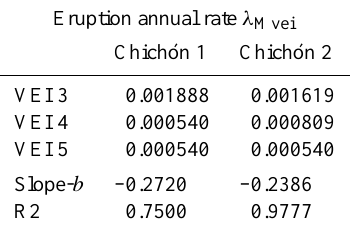
Table 6. Eruptive regimes and calculated parameters of the MOED for the eruptive sequence of El Chich´on volcano (VEI ≥ 3). The global rates for the 3707 and 7772years BLE periods are 0.026976 and 0.014153 eruptions per decade respectively. The regime rates are also in eruptions per